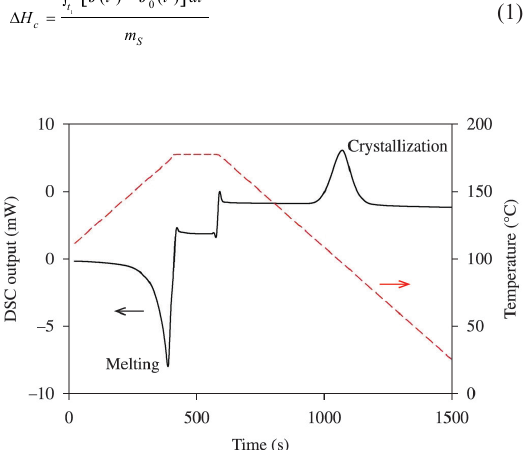
Figure 3. Decrease of PHB crystallinity upon addition of 1% PS as a function of the cooling rate. The trend seen above was observed with all